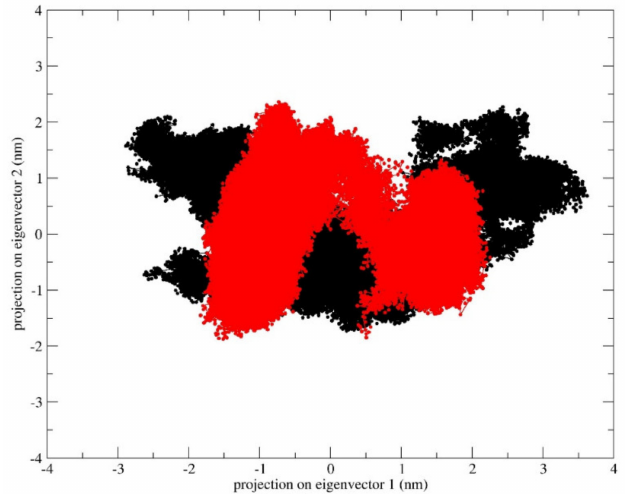
Figure 4. Projections of the inward-facing state (black) and outward-facing state (red) trajectories on the common essential subspace, as defined by the two principal